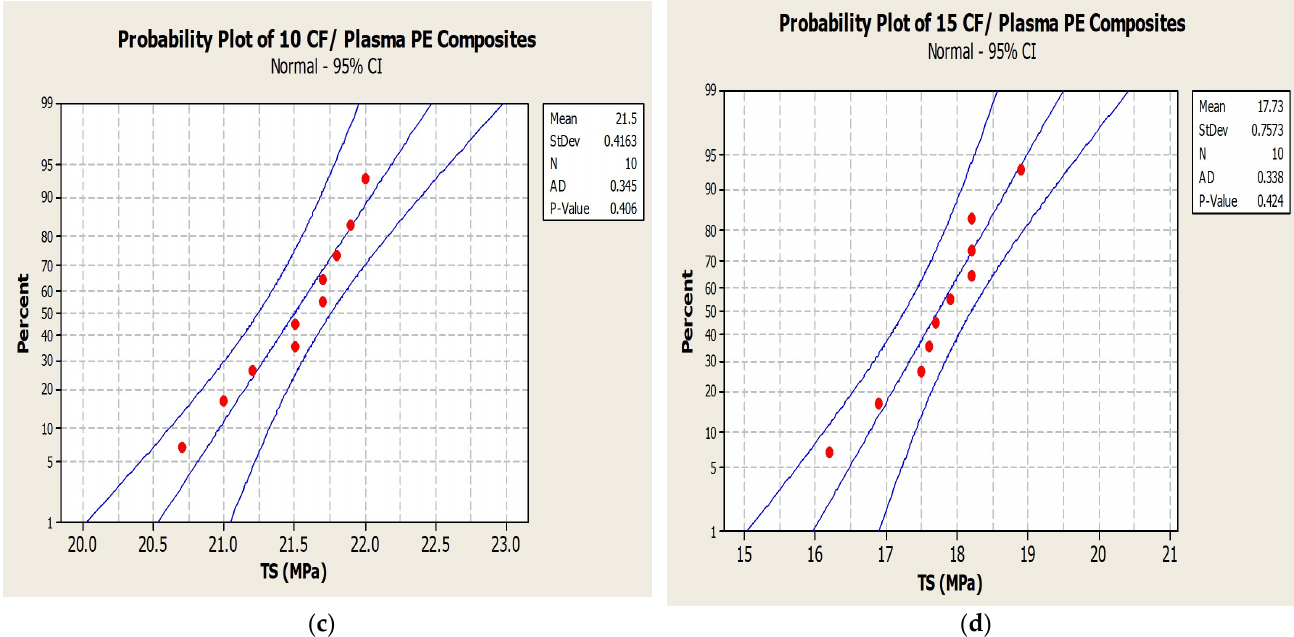
Figure 8. Normal probability plot for tensile strength: ( a ) 3% CF/plasma PE, ( b ) 5% CF/plasma PE, ( c ) 10% CF/plasma PE and ( d ) 15% CF/plasma PE combinations.